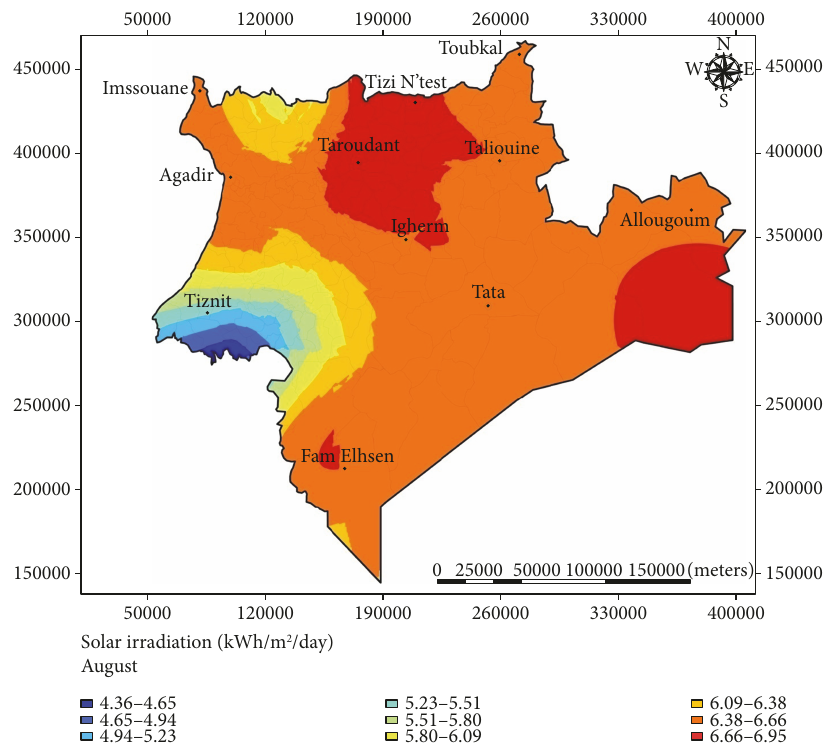
Figure 16: Solar energy potential map of the Souss-Massa area for the month of August as estimated by the ANN and designed with the Kriging interpolation